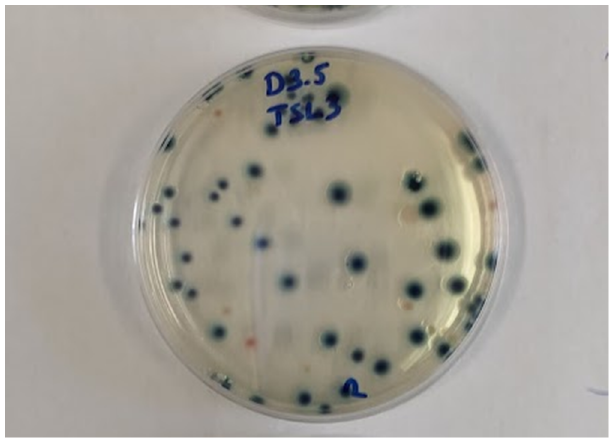
Figure 3. Blue discoloration of E. coli colonies on ChromoBio Coliform